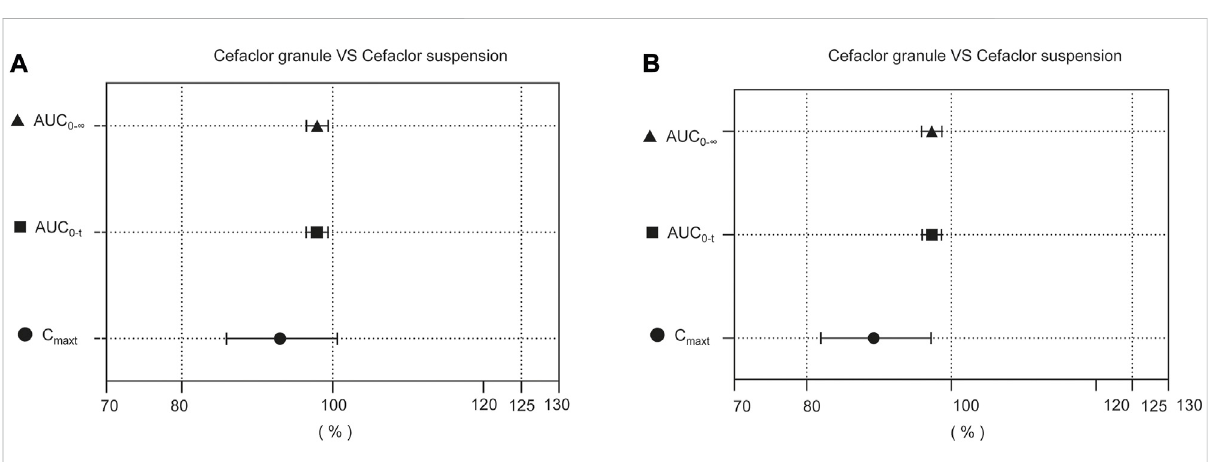
FIGURE 3 BioequivalenceanalysisofCefaclorgranuleandCefaclor suspension. ThebioequivalenceanalysisofCefaclorgranuleandCefaclor suspension during fasting (A) shows the ratio range of the main PK parameters of Cefaclor granule and Cefaclor suspension with 90% CI. The bioequivalence analysis of Cefaclor granule and Cefaclor suspension in postprandial state (B) shows the ratio range of the main PK parameters with 90% CI (bioequivalence was declared if the 90% CIs were within the prespeci fi ed acceptable ranges of 80 – 125%). AUC0-t: AUC of the analyte in the plasma over thetime interval from time zero to thelast measurable concentration; AUC0- ∞ :AUC ofthe analyte inthe plasma over the time interval from time zero to in fi nity; Cmax: maximum observed drug concentration in the